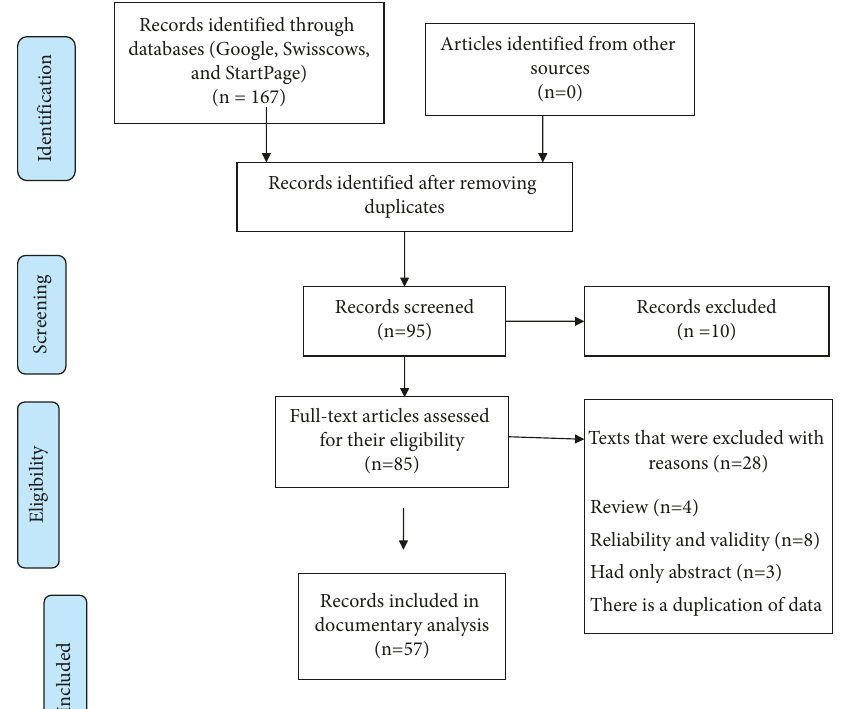
Figure 1: PRISMA flowchart for the selection of